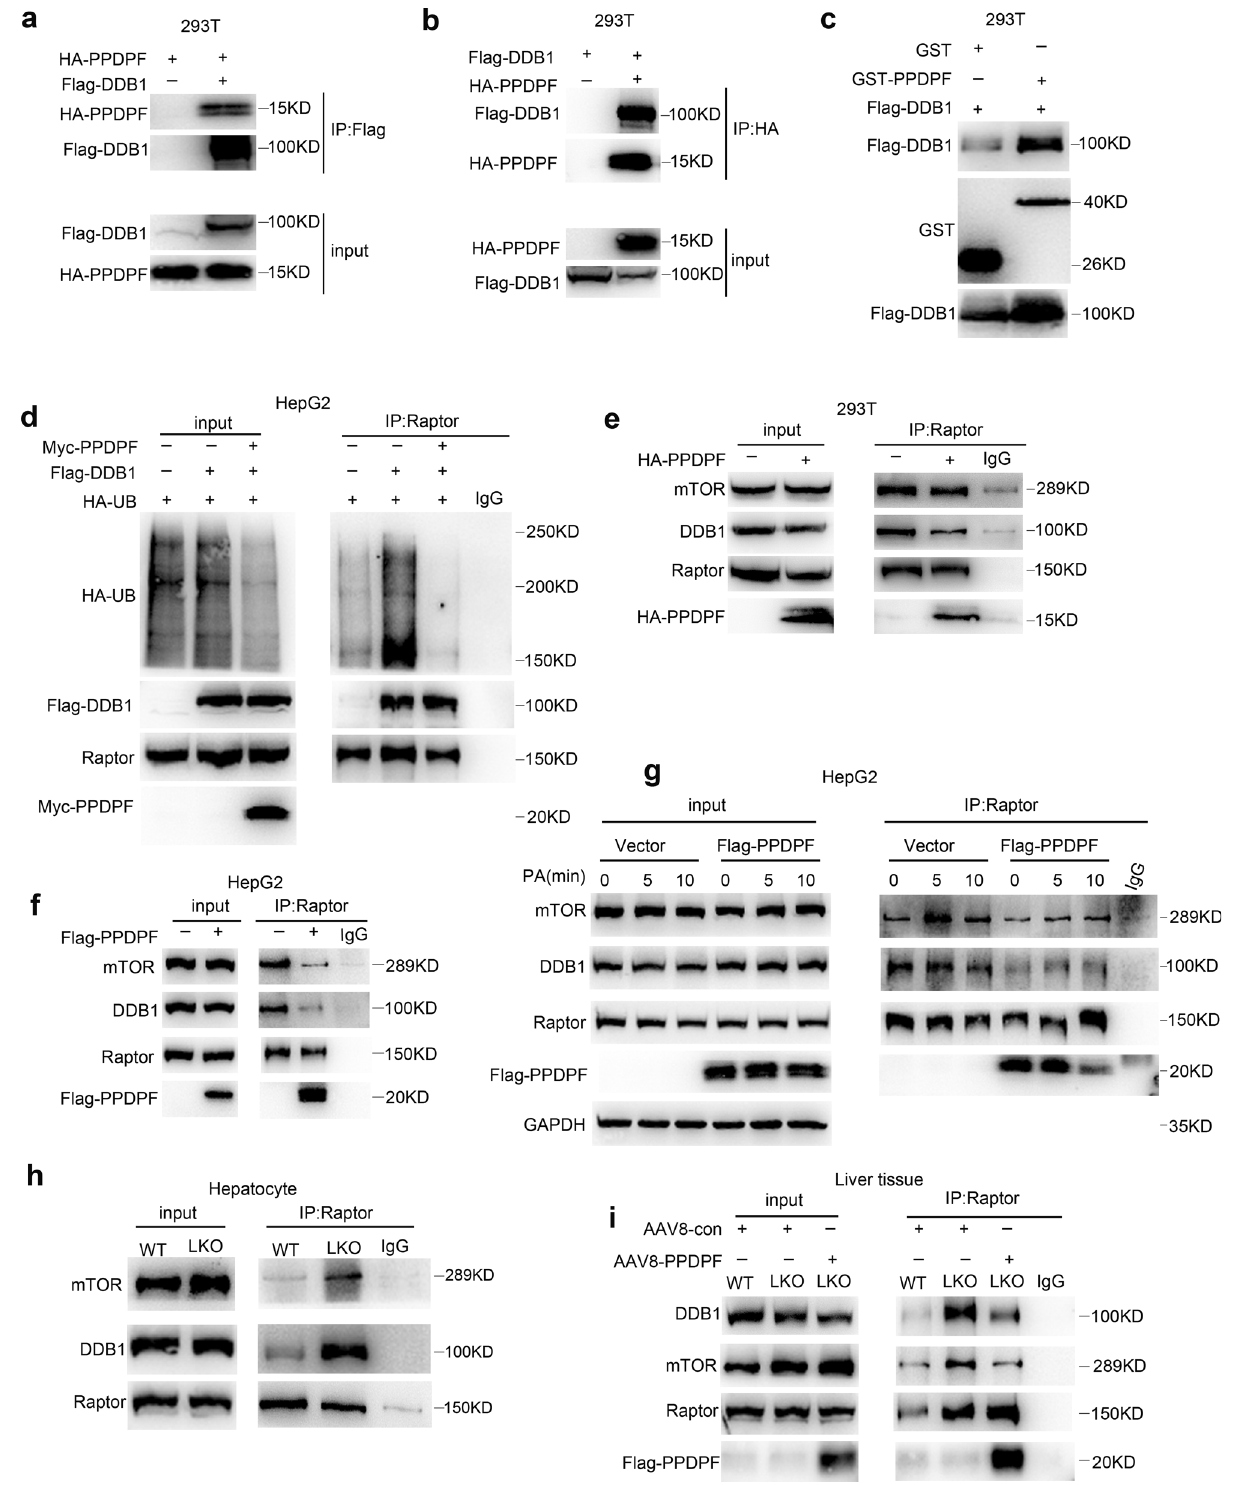
Fig. 7 PPDPF disrupts the interaction between Raptor and DDB1. a , b The interaction between PPDPF and DDB1 is detected by Co-immunoprecipitation assay in 293T cells co-transfected with Flag-DDB1 and HA-PPDPF. c GST pull-down is performed to con fi rm the interaction between PPDPF and DDB1, puri fi ed GST as the control. d PPDPF inhibits DDB1-mediated increase in Raptor ubiquitination. e , f PPDPF inhibites Raptor-DDB1 and Raptor-mTOR interaction in 293T and HepG2 cells by co-immunoprecipitation with Raptor antibody. g The interaction between Raptor with DDB1, mTOR is examined by co-immunoprecipitation upon PA stimulation in control and PPDPF-overexpressing HepG2 cells. h Raptor-DDB1 and Raptor-mTOR interaction in primary hepatocytes isolated from PPDPF-WT and PPDPF-LKO mice upon PA stimulation. i AAV-mediated reintroduction of PPDPF in the liver of LKO mice inhibits the Raptor-DDB1 and Raptor-mTOR interaction. All experiments were repeated three times independently.